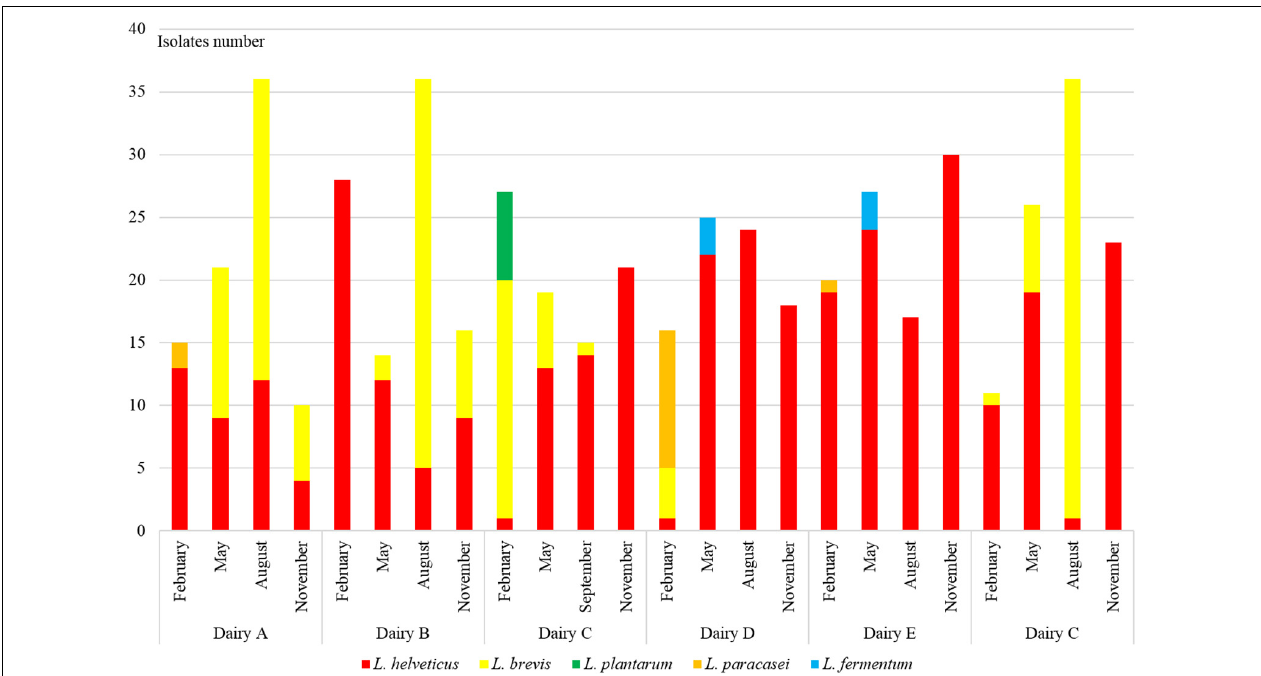
FIGURE 1 | Distribution of L. helveticus , L. brevis , L. paracasei , L. plantarum , and L. fermentum isolates in NWS samples collected from six dairy factories labeled from A to F four times in 2018 year: February, May, August, and November. At cheese factory C, the samples were collected at the end of September because in August the Trentingrana production